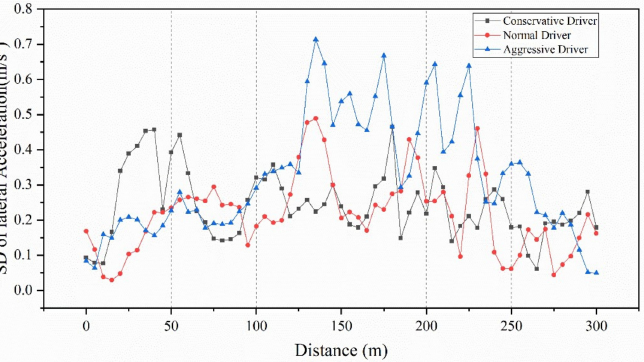
Figure 7. Standard deviation (SD) of lateral acceleration for three types of